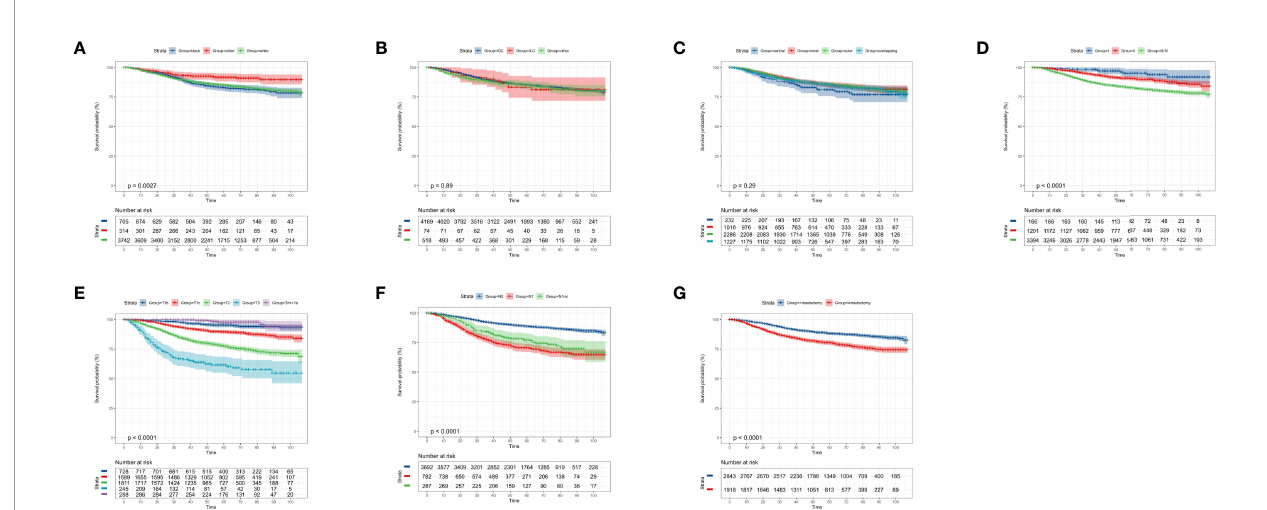
FIGURE 5 | Kaplan – Meier cancer-speci fi c survival analysis of 4,761 women aged 70 years or older with primary operable, triple-negative breast cancer regarding the clinicopathological characteristics. (A) Race. (B) Histology. (C) Tumor location. (D) Differentiation grade. (E) T stage. (F) N stage. (G) surgical extension. other: de fi ned as the Asian/Paci fi c Islander and American Indian/Alaska Native; Grade: I: well-differentiated, II: moderately differentiated, III/IV: poorly differentiated and undifferentiated; central: central portion of breast combined with nipple; other: other types of breast cancer. TNBC, triple-negative breast cancer; IDC, invasive ductal carcinoma; ILC, invasive lobular carcinoma. Tick marks indicate censored